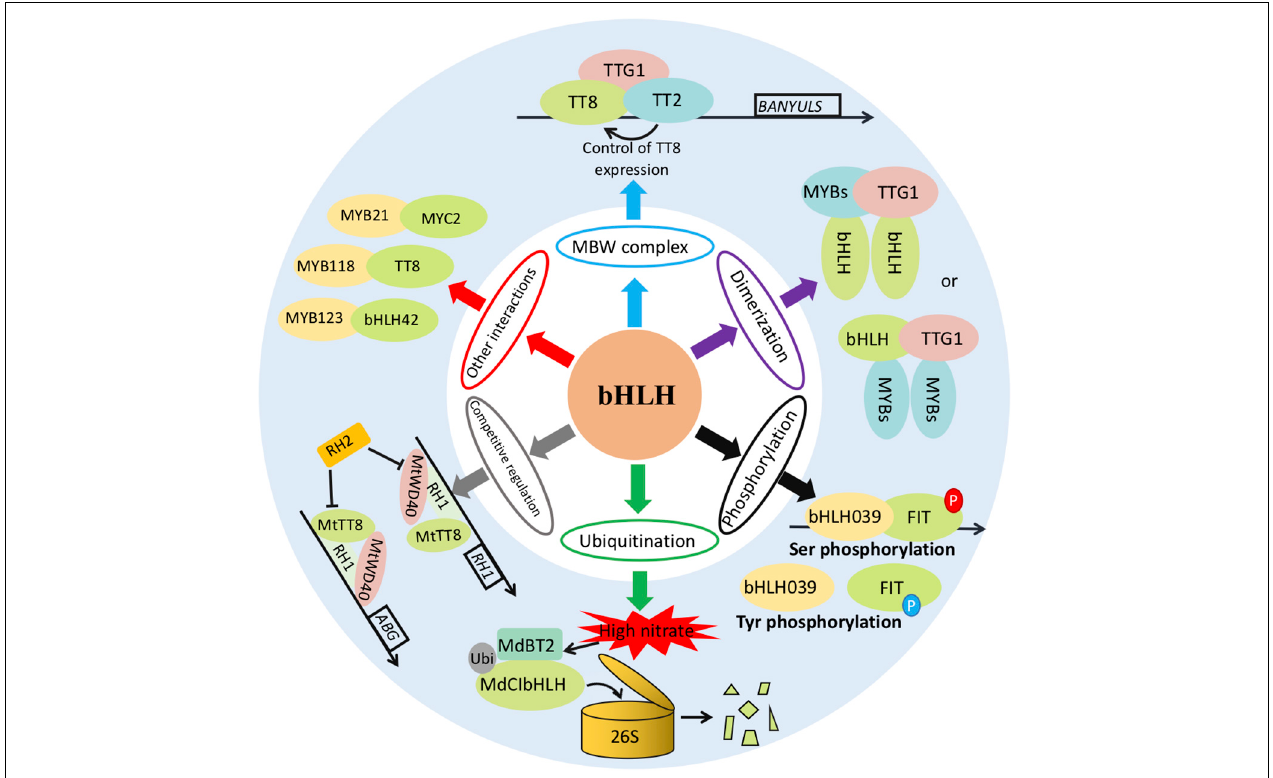
FIGURE 1 | Different regulatory patterns of bHLH transcription